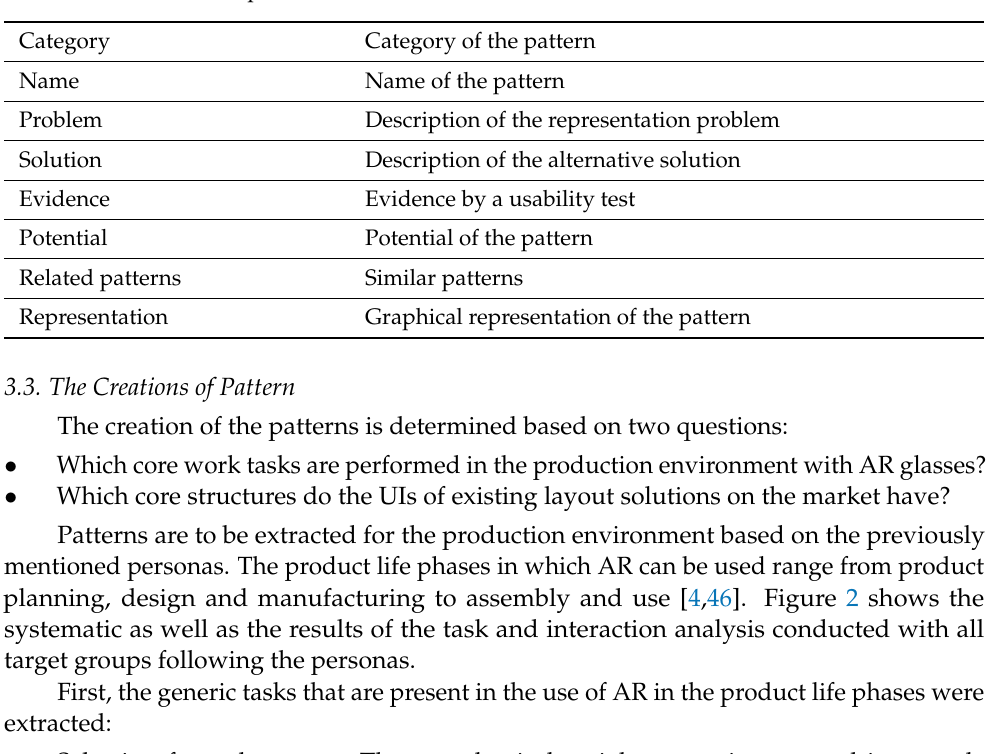
Table 6. Structure of the